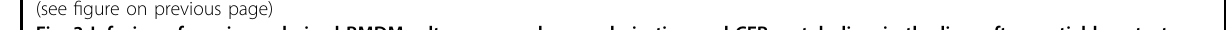
(Fig. 4B). To examine the effects of BMDM infusion on liver regeneration and liver injury, the expression levels of proliferation marker and apoptotic maker in the liver tis- sues were measured. Immunoblotting demonstrated that